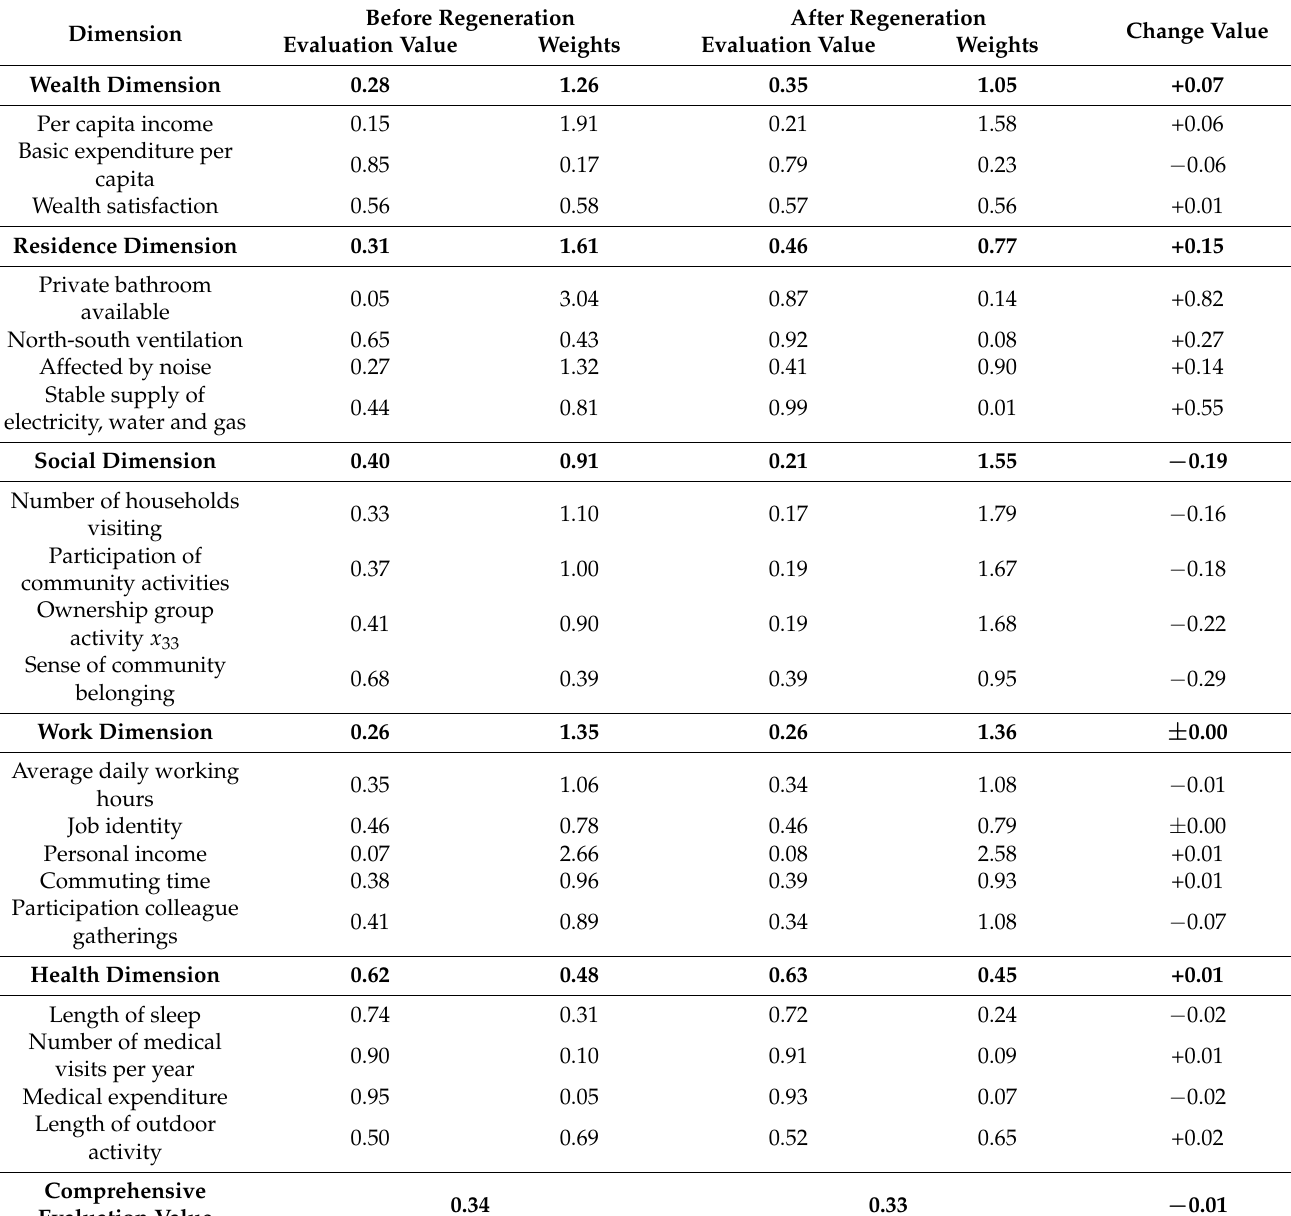
Table 2. Measurement results of state